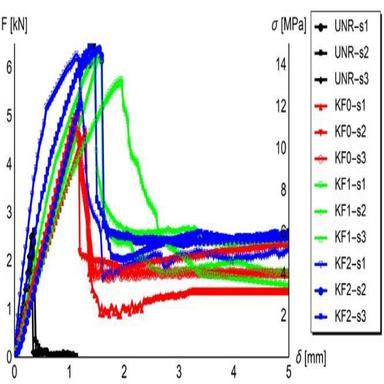
Force- and stress-deflection curves of the unreinforced mortar specimens (UNR), and the specimens reinforced with KF0, KF1 and KF2 fibers.